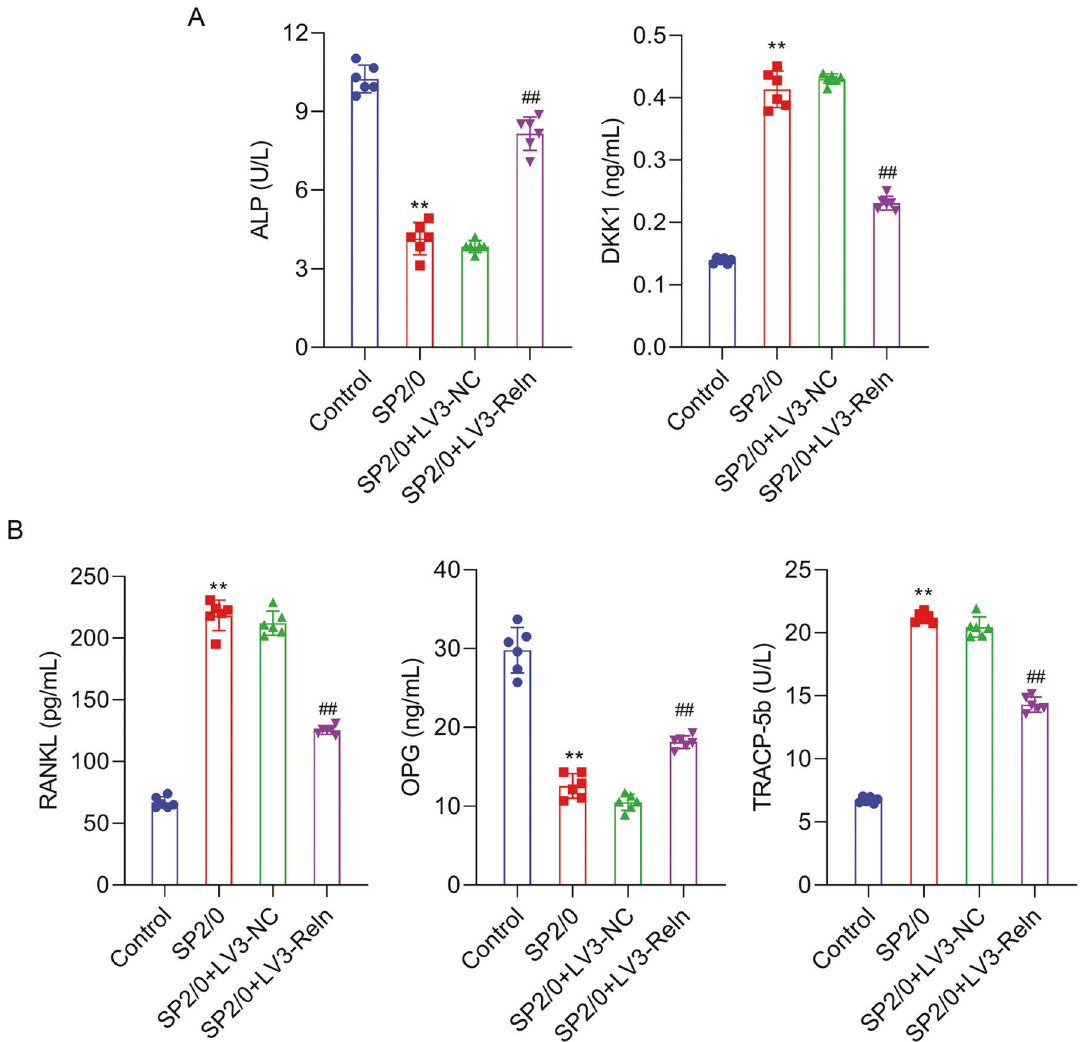
Fig. 3 Inhibition of Reelin rebalanced osteoclasts and osteoblasts activity. A Serum osteoblast-related factors (ALP and DKK1) quanti fi ed by ELISA. B Serum osteoclast-related factors (RANKL, OPG, and TRACP-5b) quanti fi ed by ELISA. Reln stands for Reelin. ** p < 0.01 vs. Control group; ## p < 0.05 vs. SP2/0